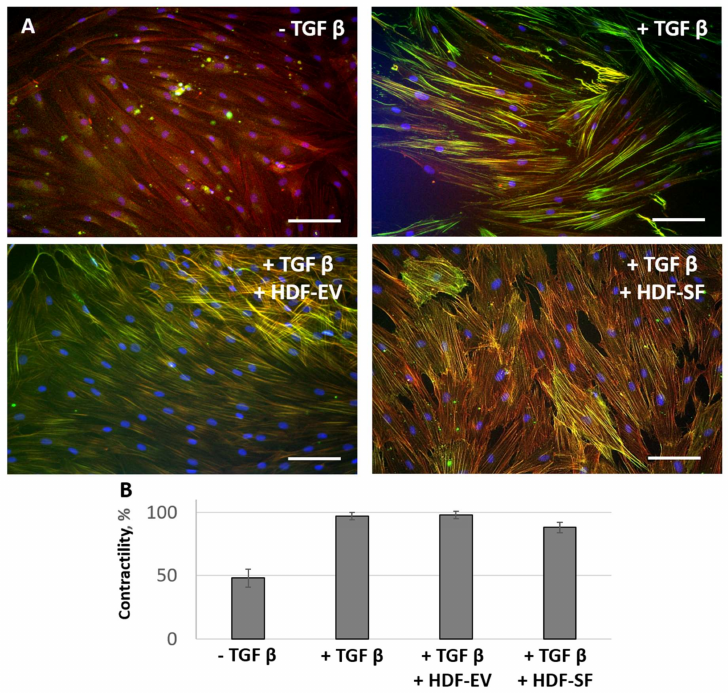
Figure 5. Human dermal fibroblasts conditioned medium (HDF-CM) fractions added simultaneously with TGFbeta were not able to prevent the TGFbeta-induced aSMA redistribution into stress fibers and contractile activity of fibroblasts. The expression of aSMA in serum-free cultured control fibroblasts ( − TGFbeta), in fibroblasts after exposure to TGFbeta ( + TGFbeta), and TGFbeta with the components of HDF-CM ( + TGFbeta + HDF-EV; + TGFbeta + HDF-SF). ( A ) Immunofluorescent analysis (aSMA (green), phalloidin (red), DAPI (blue)). Scale bar: 100 µ m. ( B ) Collagen contraction